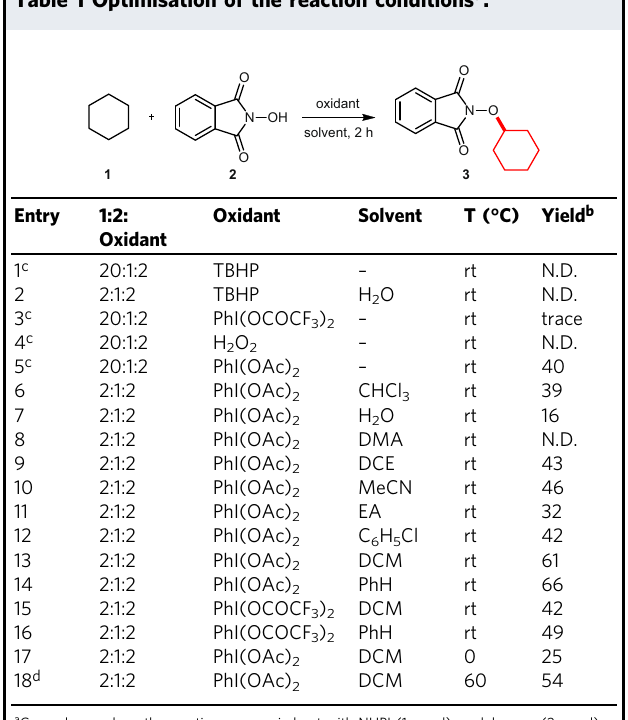
Table 1 Optimisation of the reaction conditions a .